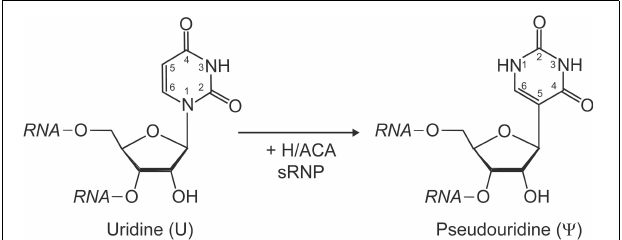
FIGURE 1 | Schematic representation of the isomerization of a uridine to pseudouridine by H/ACA sRNPs. Pseudouridine is characterized by a unique C–C glycosidic bond linking C1 (cid:48) of the ribose with C5 of the base as well as an extra imino group (N1) with hydrogen bonding potential within the base. The Watson-Crick face in pseudouridine is unchanged and allows base-pairing with